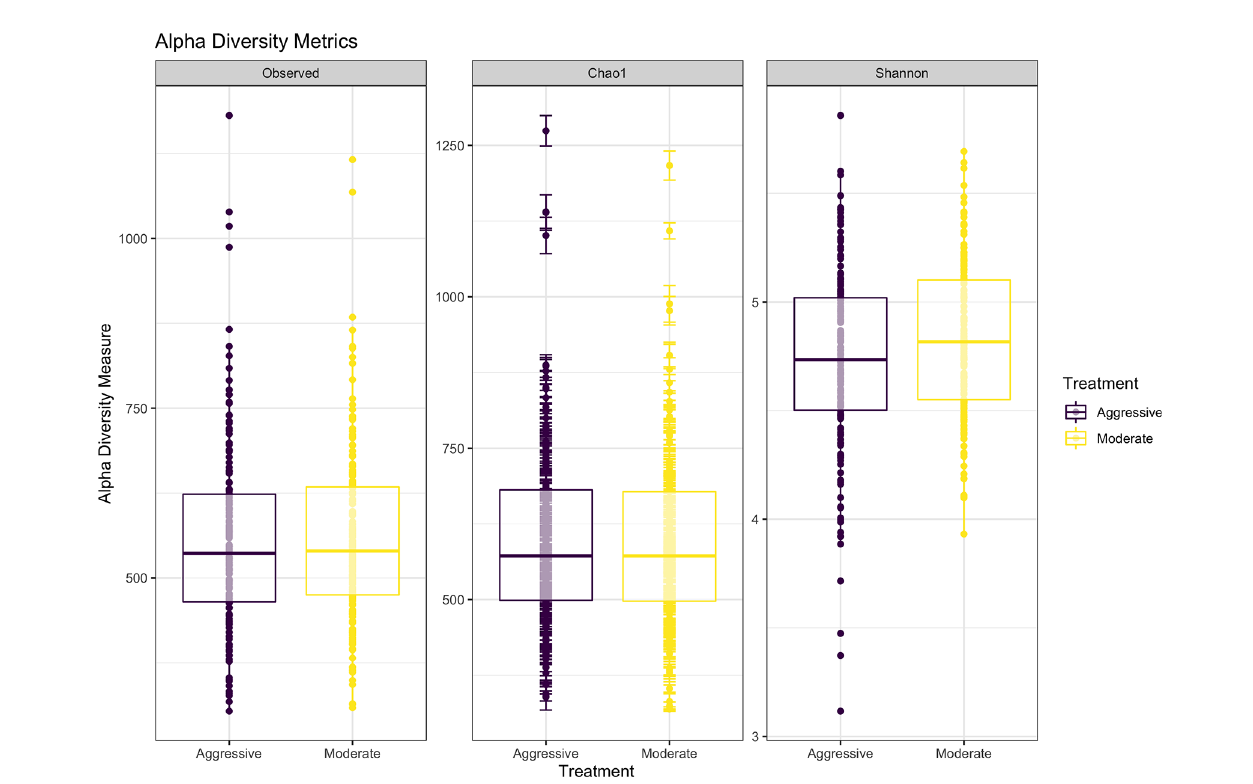
FIGURE 1 | Alpha-diversity metrics for bacterial communities with observed abundances of communities, expected abundances (Chao1), and richness and diversity measured with Shannon diversity index. Aggressive treatments are represented in purple and moderate treatments are represented in yellow. Signi fi cant differences were only noted in the Shannon diversity index between treatments ( P <